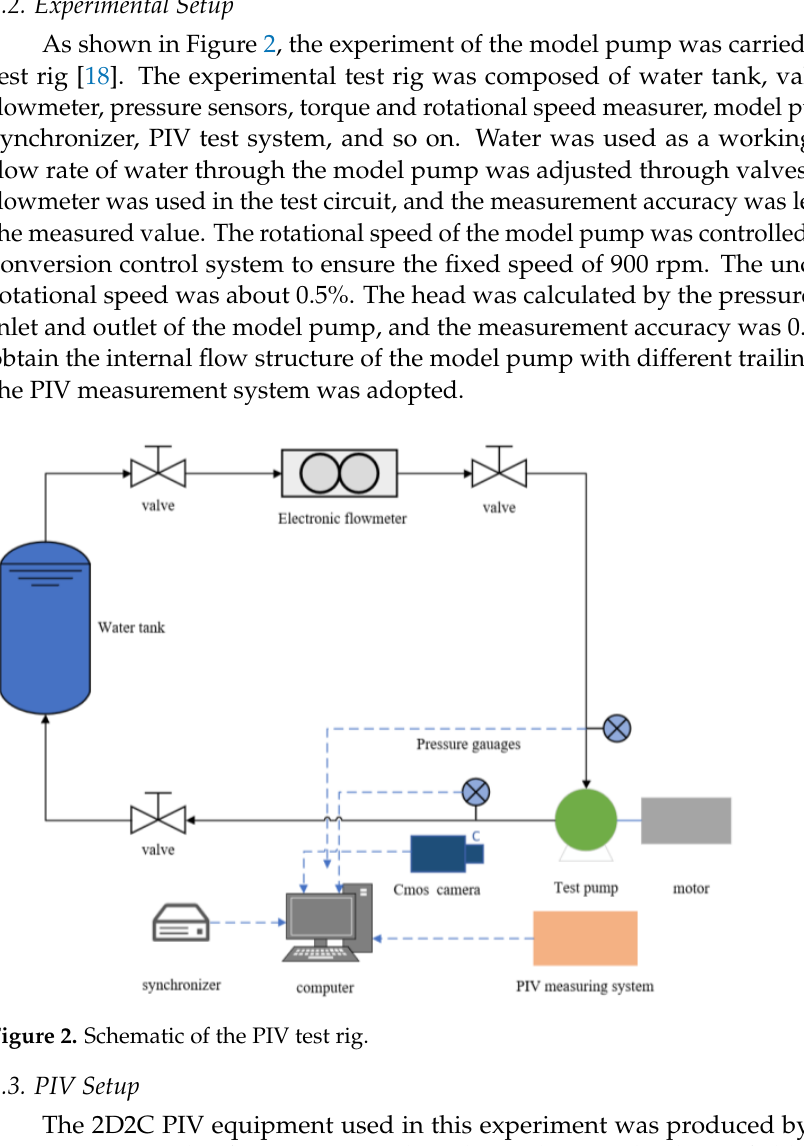
Table 1. Geometric parameters of the suction side of impellers and the model pump.